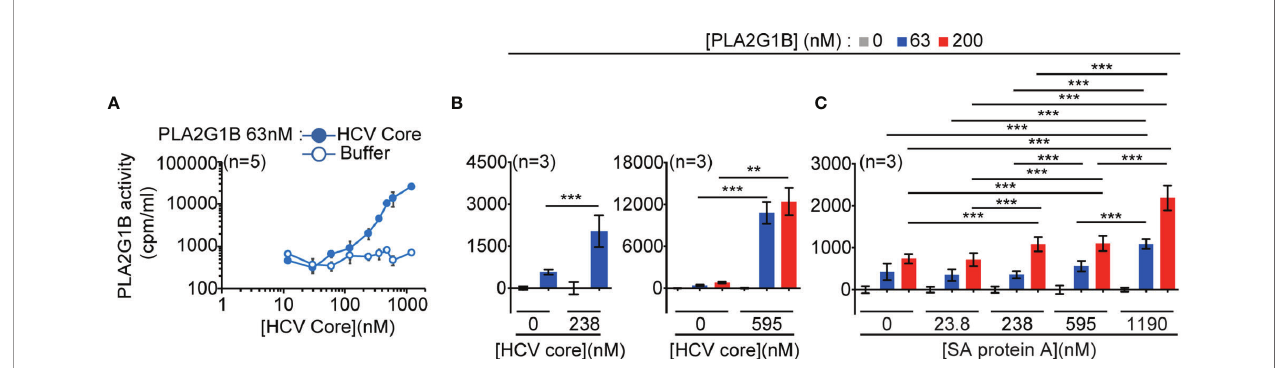
FIGURE 3 | PLA2G1B activity on CD4 T cells is increased by several gC1qR-binding microbial proteins. (A, B) HCV core increases PLA2G1B activity on human CD4 T cells in a dose-dependent manner. [3H]-AA-labeled CD4 T cells were incubated alone or with PLA2G1B (63 nM or 200 nM) in the presence or not of several concentrations of recombinant HCV Core protein (11.9 nM-1190 nM) or equivalent concentrations of buffer alone (Buffer for A or 0 nM for B). (C) Staphylococcus aureus (SA) protein A increases PLA2G1B activity on human CD4 T cells in a dose-dependent manner. [3H]-AA-labeled CD4 T cells were incubated alone or with PLA2G1B (63 nM or 200 nM) in presence or not of several concentrations of SA protein A (23.8 nM-1190 nM). Results are shown as the mean ± SD from a pool of fi ve experiments for A, and three experiments for B and C. ** p < 0.01 and *** p < 0.001 by the Kruskal-Wallis test followed by the Mann-Whitney test, with p-values adjusted for multiple comparisons between